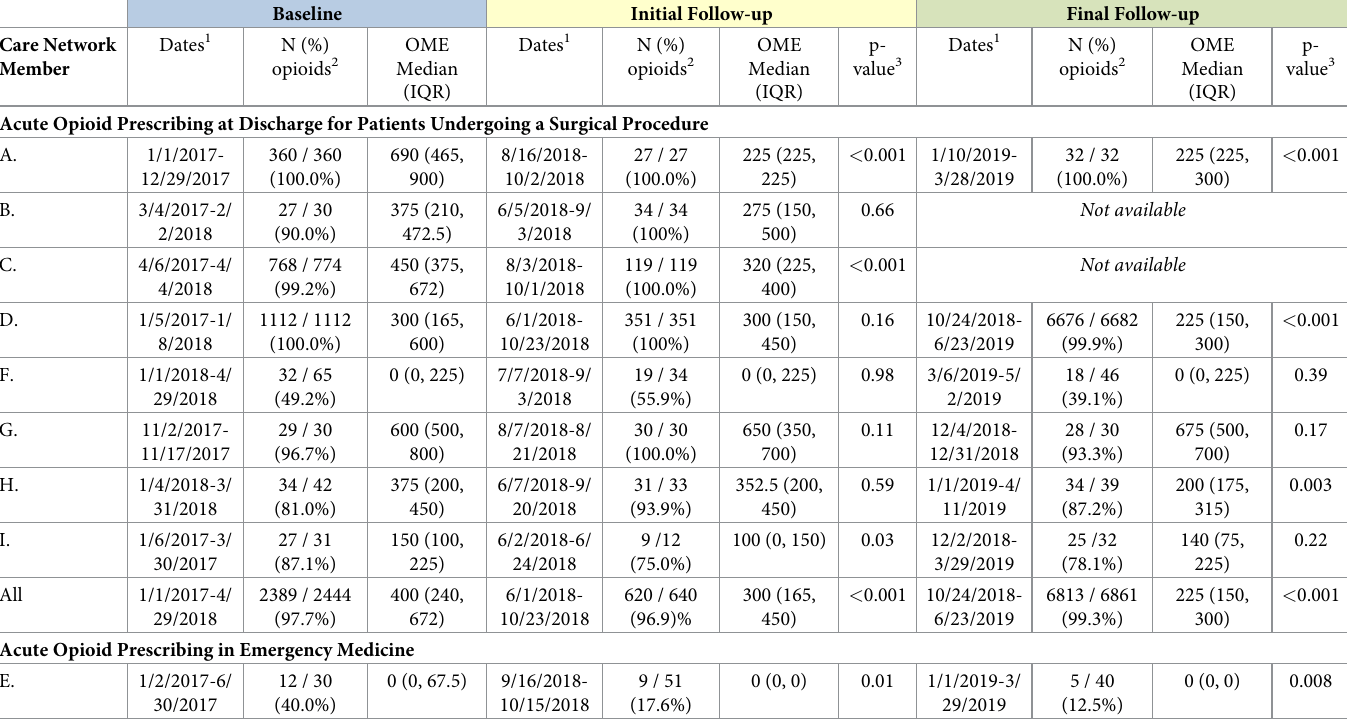
Table 2. Opioid prescribing improvement